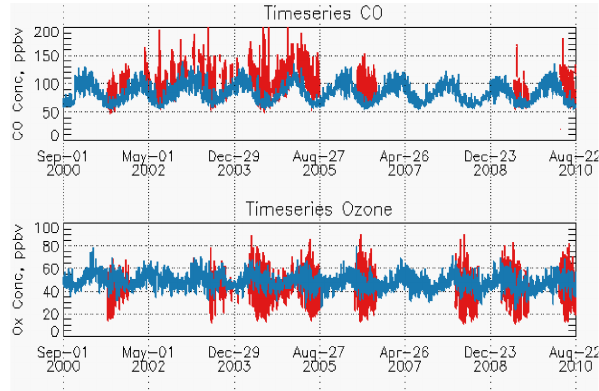
Fig. 2. Time series of CO (top) and O 3 (bottom) from Septem- ber 2000–August 2010. The observations are shown in red and GEOS-Chem output is shown in